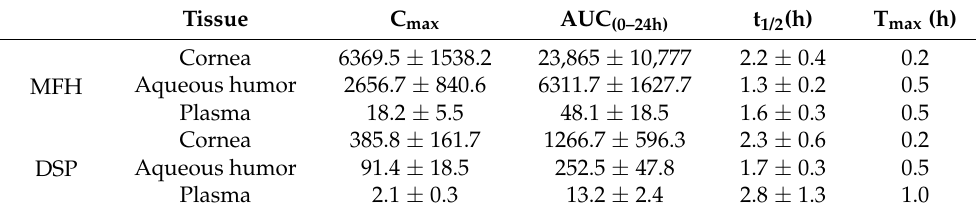
Figure 4. Concentration–time curves of MFH in rabbit cornea ( A ), MFH in rabbit AH ( B ), DSP in rabbit cornea ( C ), and DSP in rabbit AH ( D ) following single topical ocular administration. Data are shown as the mean + SD (n = 6 for cornea, AH). AH, aqueous humor; MFH, moxifloxacin hydrochloride; DSP, dexamethasone sodium phosphate. Table 5. Pharmacokinetic